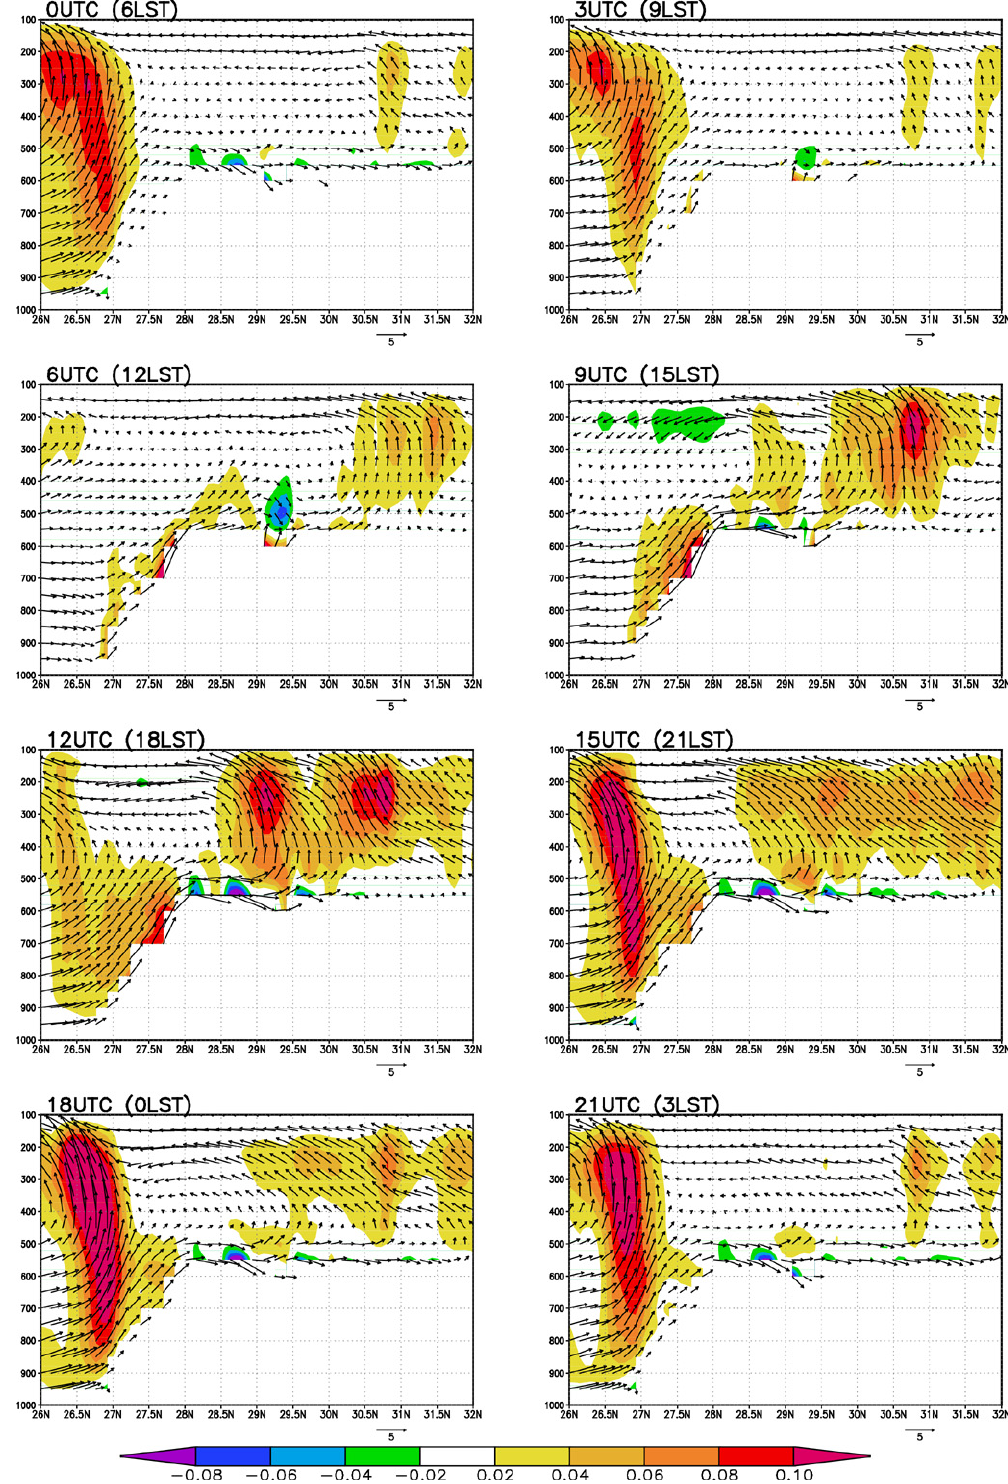
Fig. 12. Latitude-pressure cross-section averaged over 88 ◦ –92 ◦ E for vertical velocity (shaded, ms − 1 ) , and the vertical circulation vectors (v-wind and 50 times the vertical